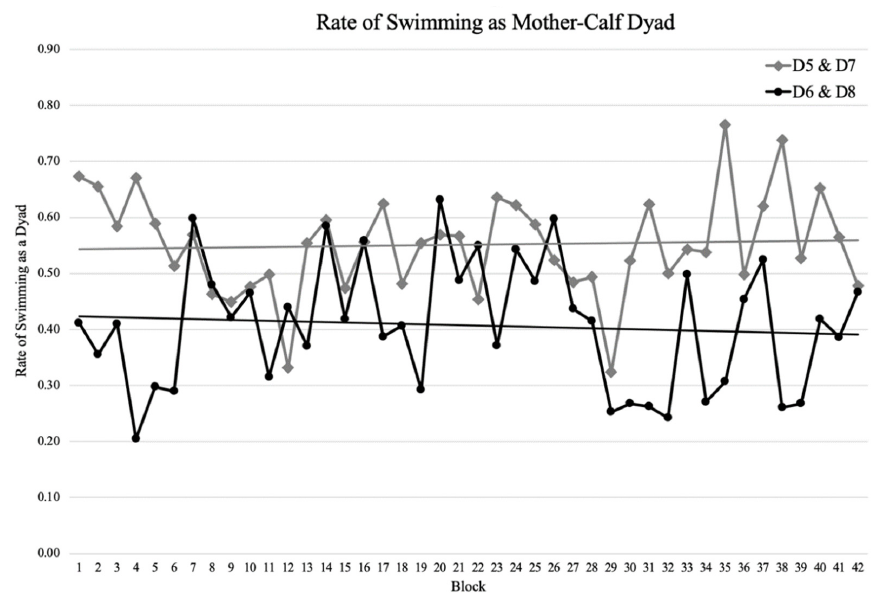
Figure 4. Rates of pair swimming of the two mother–calf dyads over the 10-month observation pe- riod.